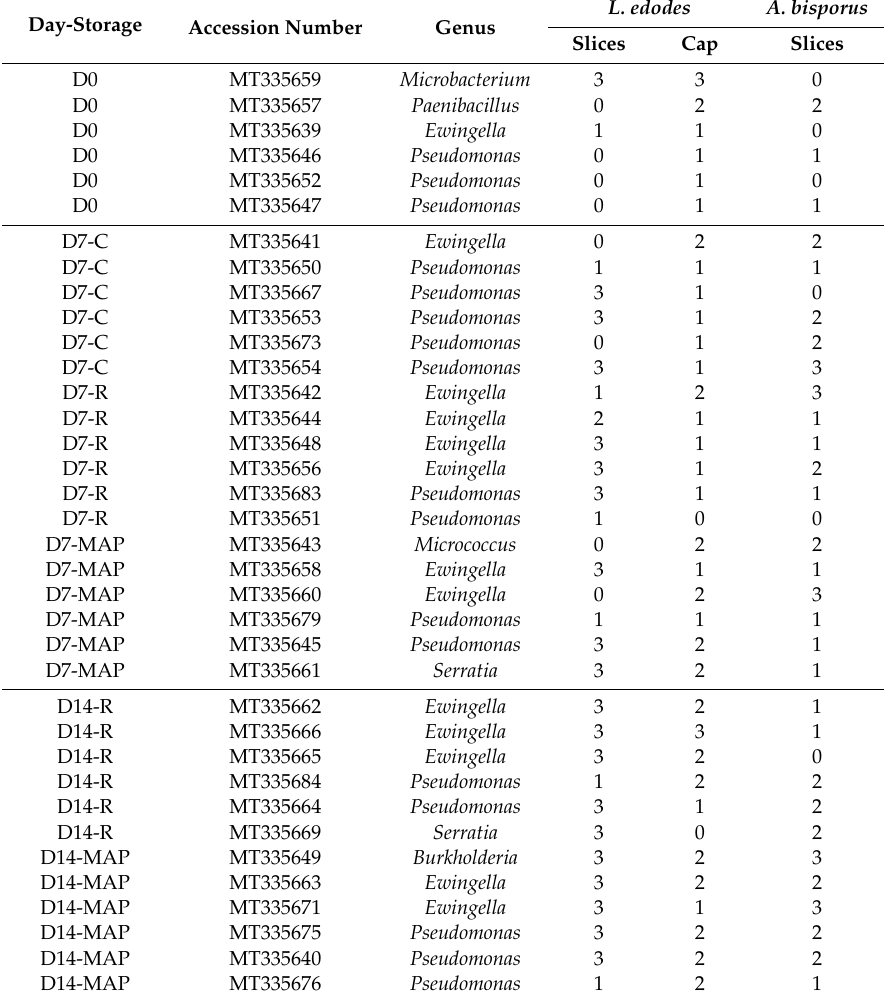
Table 3. List of the strains isolated during the microbiological analysis, Genbank accession numbers, and results of the biodeterioration evaluation with a pathogenicity test. The genus corresponds to the best BLAST hit in Genbank database for each bacterial strain, as detailed in Table S1. The pathogenicity test was performed on mushroom slices of L. edodes and A. bisporus , and on cap cuticle of L. edodes . The biodeterioration was scored on a 0–3 scale (0: no appreciable damage, 1: slight damage in the inoculation area, 2: extended damage around the inoculation area, 3: severe damage throughout the carpophore sample). Data are disaggregated by the day of storage in which the strain was retrieved (D0–D28) and by the batch from which the strain was retrieved (C: room temperature; R: refrigerated at 4 ◦ C; MAP: modified atmosphere packaging at 4 ◦